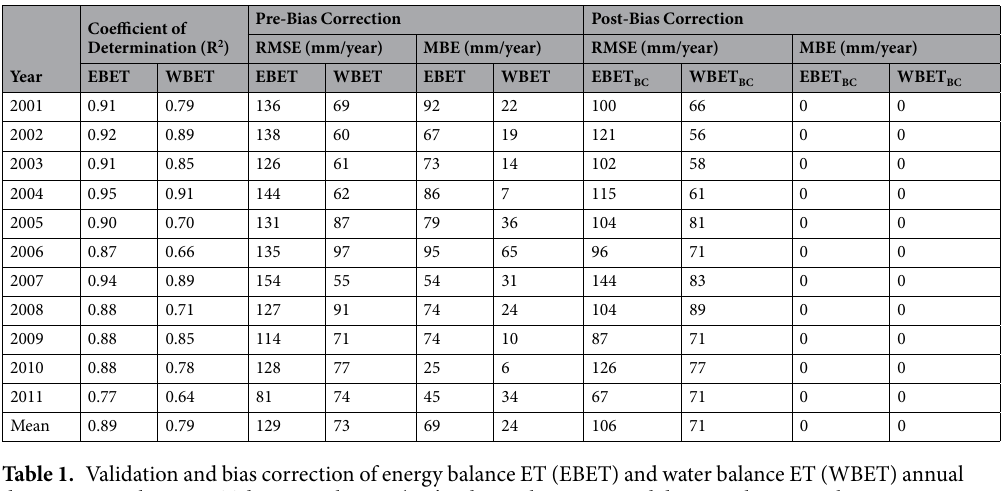
Table 1. Validation and bias correction of energy balance ET (EBET) and water balance ET (WBET) annual datasets using the MPI ET dataset. Subscript ‘BC’ indicates bias corrected dataset. Please note bias correction has been performed on the subset of the grassland HUCs (on HUCs with > 90% grassland